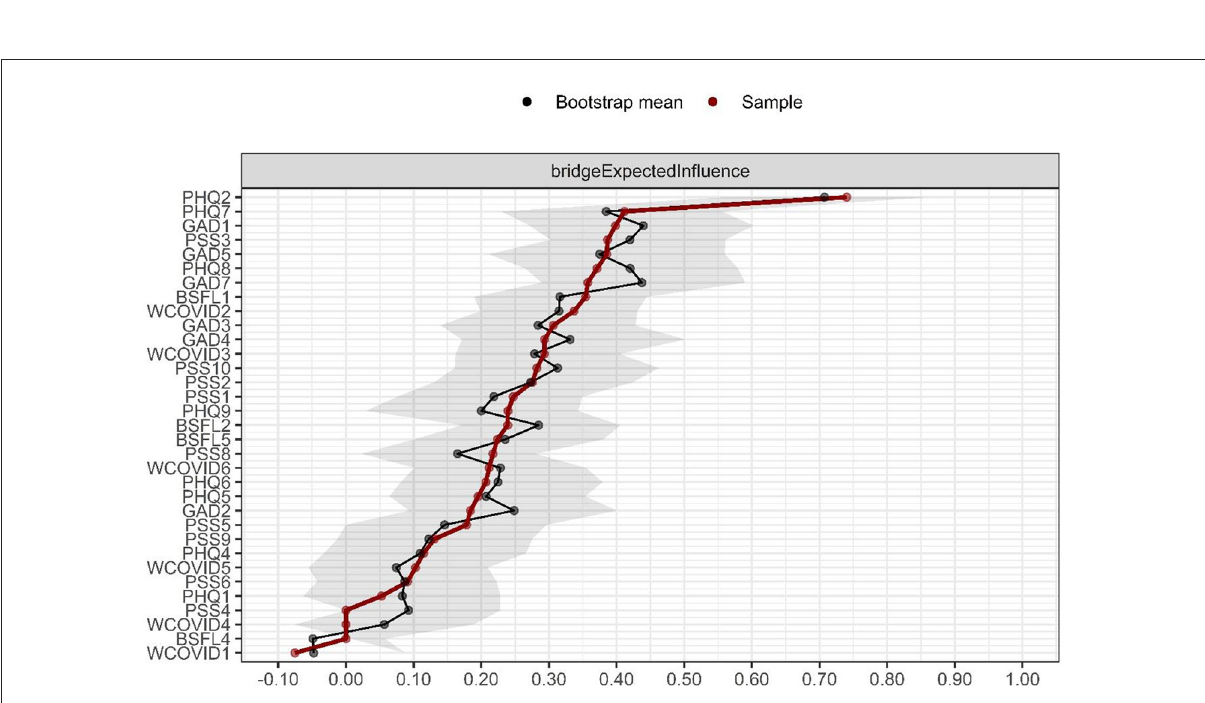
FIGURE3 Expected Bridge Influence (EBI). Values are given as Z-scores, with higher values indicating more influential nodes in the